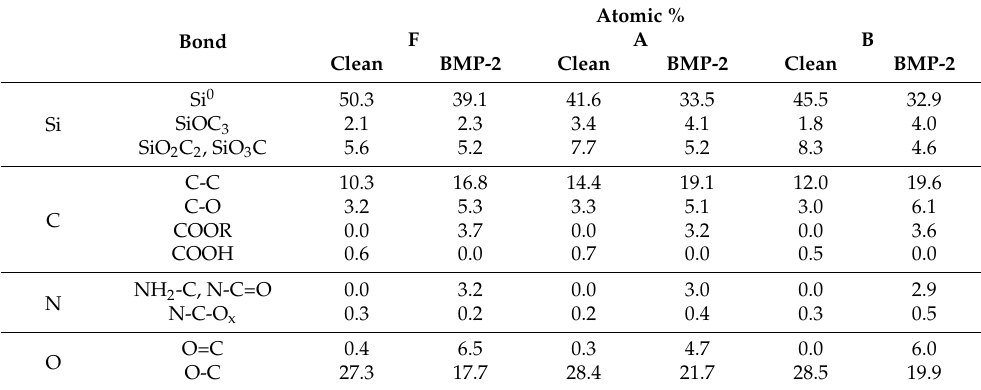
Table 3. Atomic percentages obtained from deconvolution of high resolution XPS spectra after sample cleaning (clean) and after BMP-2 grafting (BMP-2) for the flat control (F) and the nanostructured Samples A and B. (Atomic % represented as % of total peak